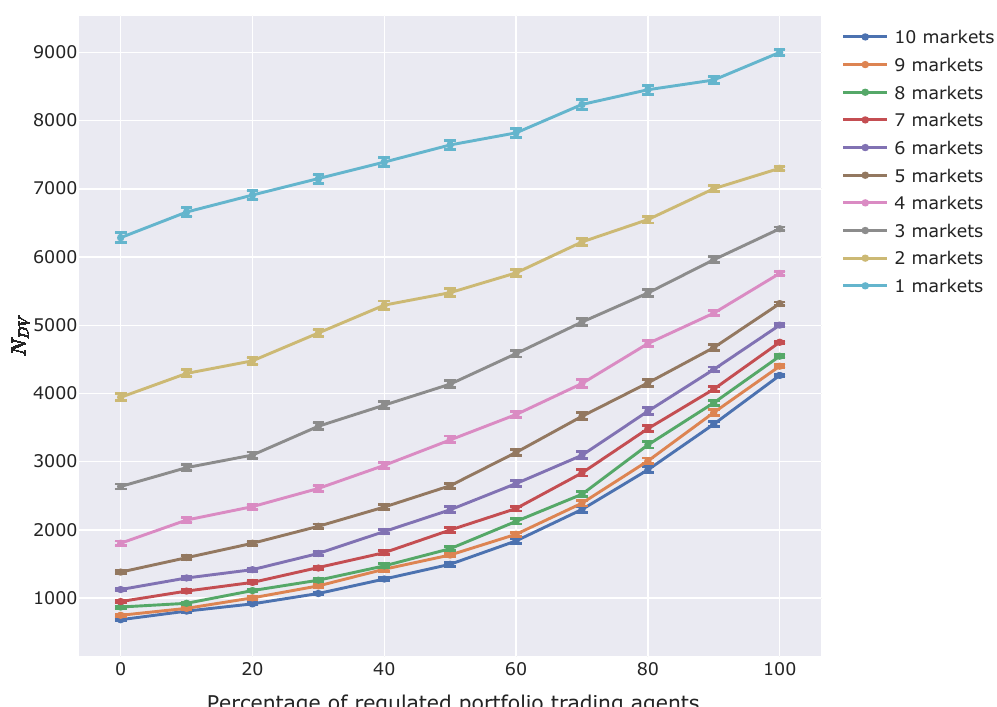
Figure 7. N DV graph assessing the effect of capital adequacy ratio (CAR) regulation. The horizontal axis is the percentage of regulated portfolio trading agents among all non-regulated and regulated portfolio trading agents. The vertical axis is the number of steps in which the market price is below exp ( − 0.1 ) times the fundamental price. (Details are explained with Equation (14)). Each series of plots shows a simulation series for a certain number of markets. Error bars show standard